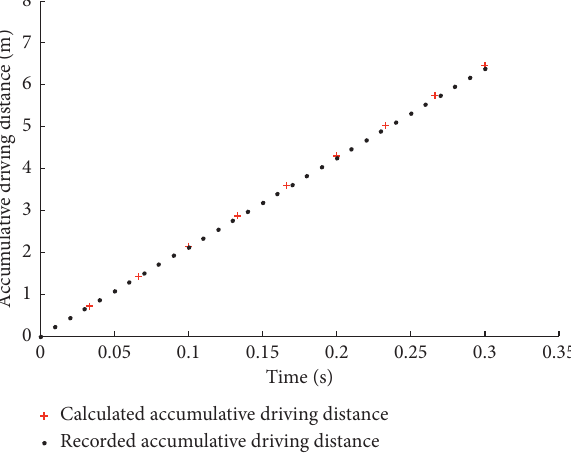
Figure 19: Compared analysis of S and S